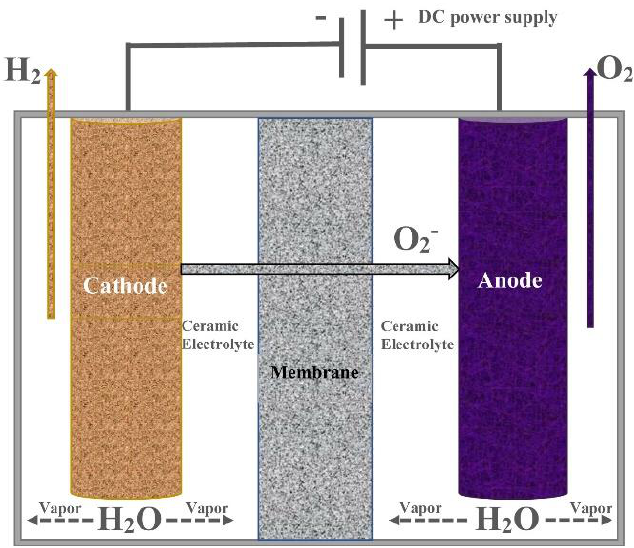
Figure 9 . Solid oxide electrolysis and chemical species. Reproduced with permission from [114]. A summary of a SOE system for membrane-based electrolysis is shown in Table 3. SOE operating temperatures and voltages range from 700 to 800 ◦ C and 0.95 to 1.40 V, respectively. The majority of the SOE systems use water as the electrolysis reactant. Table 3. Summary of SOE system for hydrogen